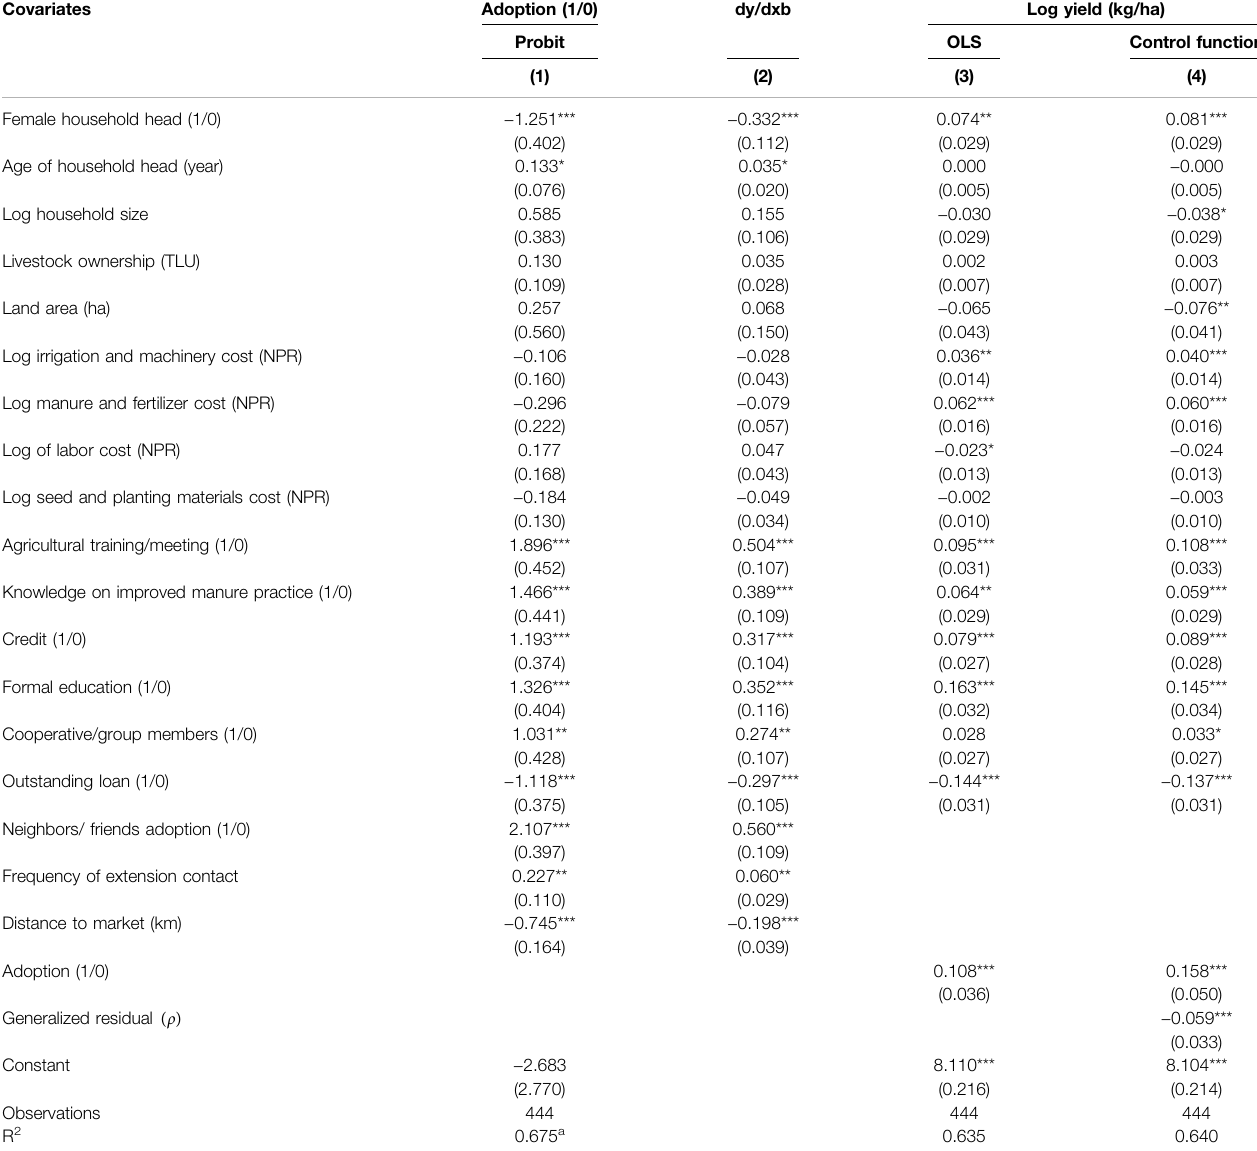
TABLE 2 | Probit, OLS, and control function approach to estimate crop yield function.